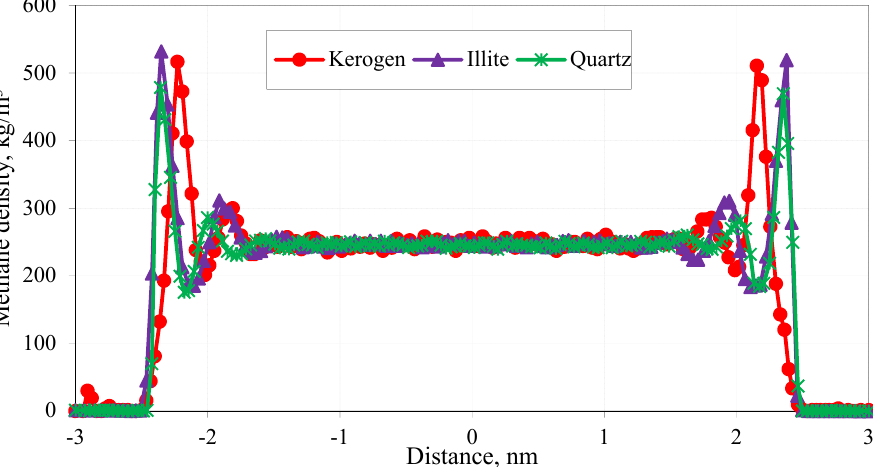
Figure 13. Methane density distribution curve in quartz slit-shaped pore space (including pore walls).